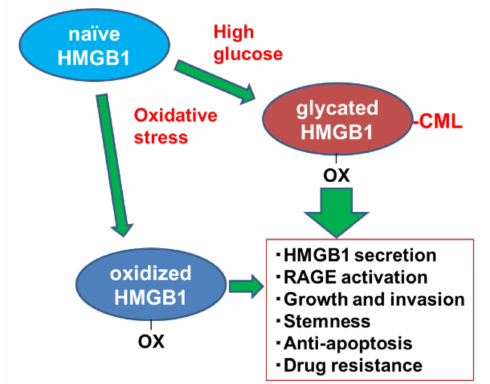
Figure 5. Conclusion of this study. Glycated HMGB1 modified from naïve HMGB1 by high-glucose conditions and oxidative stress enhances pro-tumoral features. HMGB1, high mobility group box- 1; OX, oxidized cysteine residue; CML, N ε -(Carboxymethyl ) lysine ; RAGE, receptor for glycated end